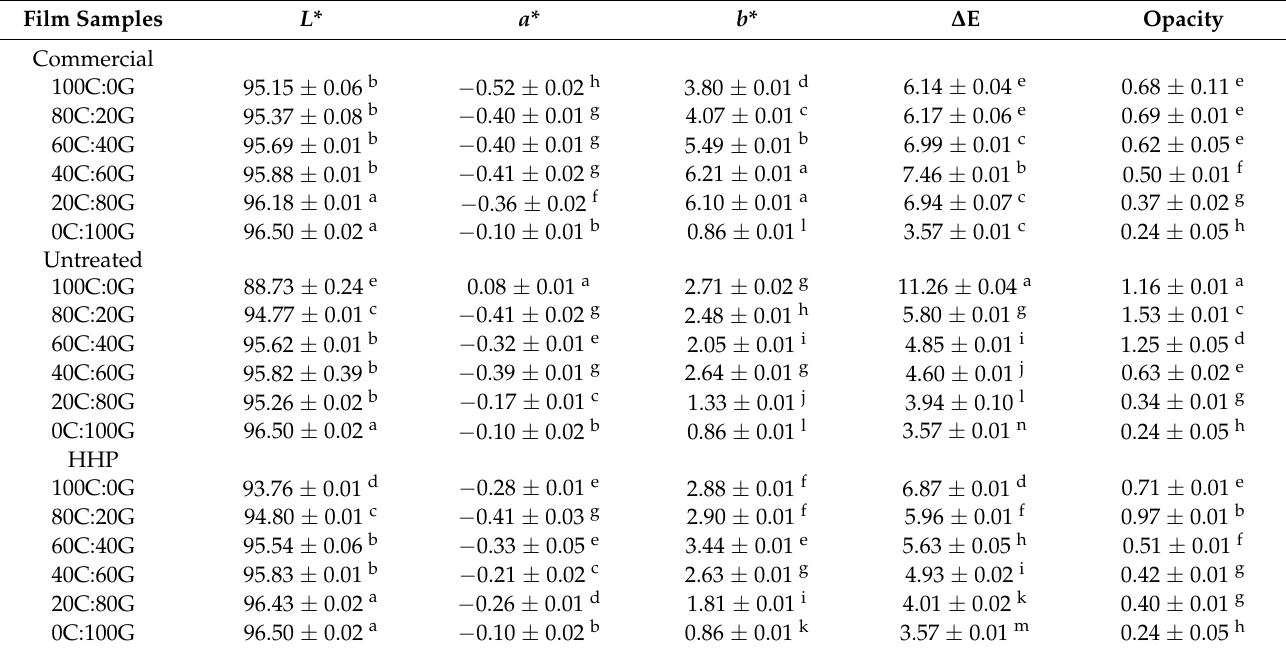
Table 3. Color and opacity of composite